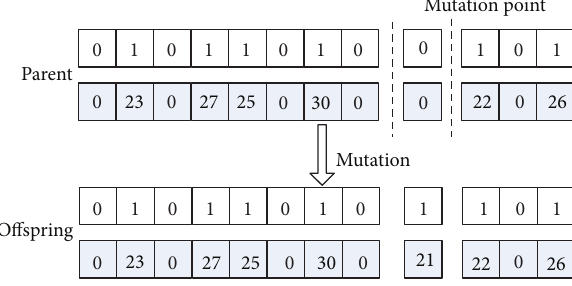
Figure 5: Illustration of mutation operation.